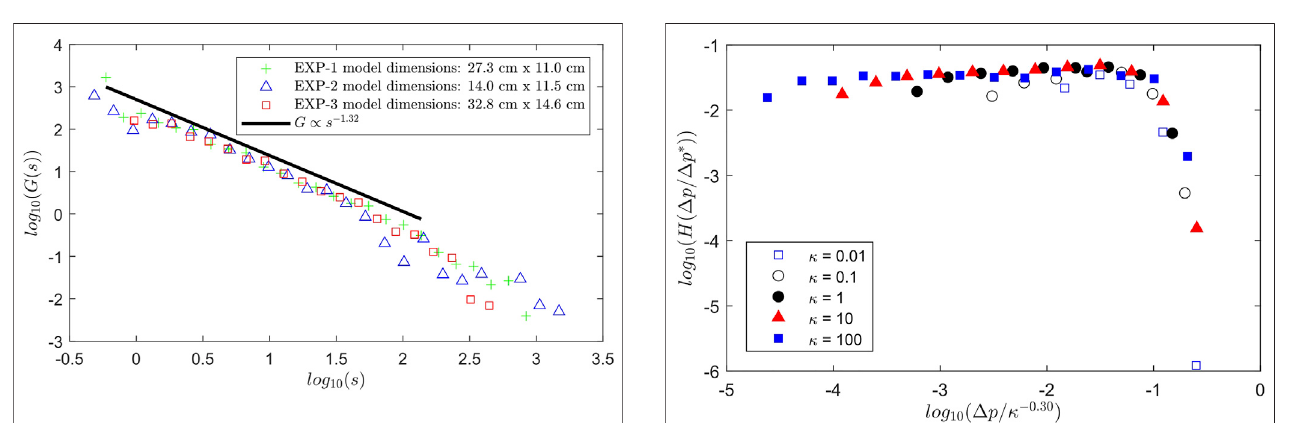
FIGURE 6 | Burst size distribution G ( s ) from slow drainage experiments. The line has a slope of − 1.32 corresponding to the results predicted by the analytical prediction Eq. 21 . The data for EXP-2 (blue triangles) has been shifted vertically by 0.4. Data from Ref. [71].